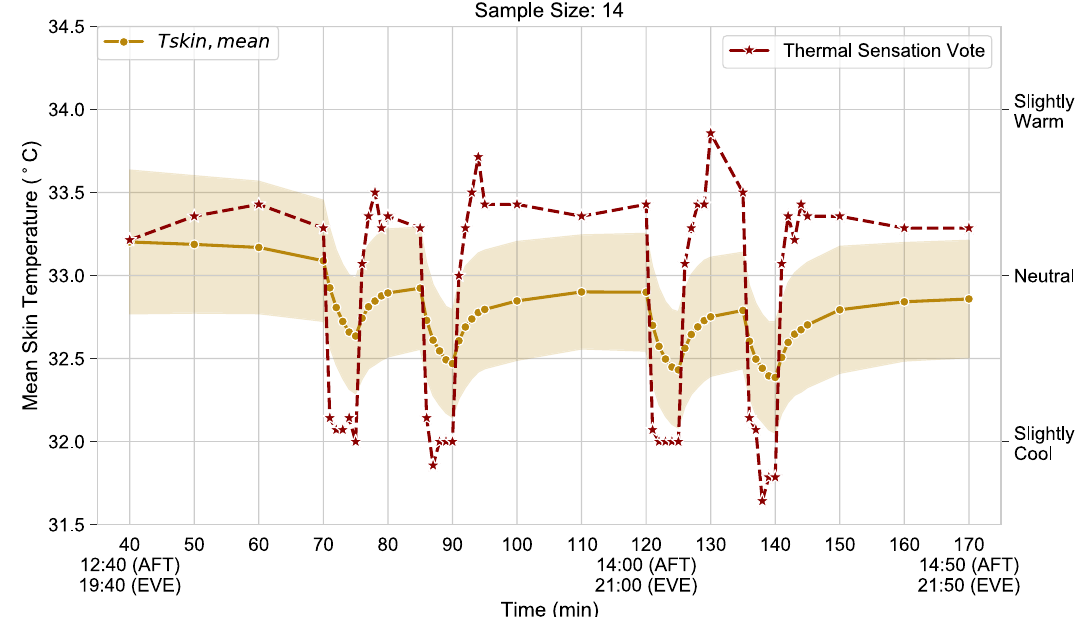
Figure 4. Mean skin temperature (left) and thermal sensation vote (right) over the course of the experiment. Shaded bands represent one standard